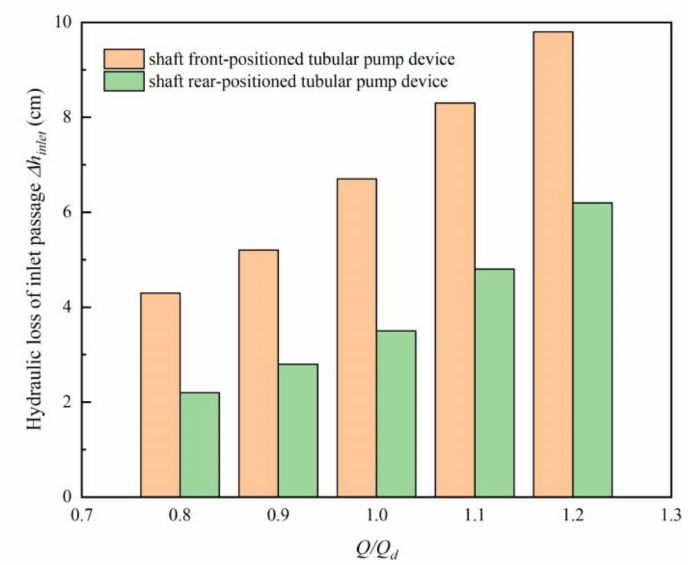
Figure 10. Hydraulic loss of inlet